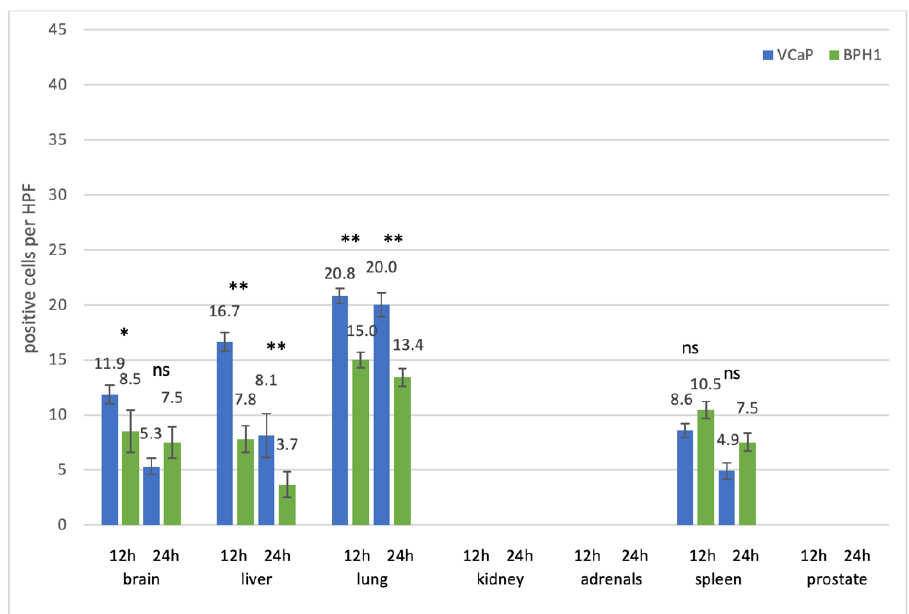
Figure 6. Uptake of fluorescence labeled VCaP and BPH1 EVs after intravenous injection. The number of EV-positive cells per high power field (HPF) is given for each organ and each time point. Columns for VCaP EVs are depicted in blue, those for BPH1 EVs in green. Medians +/− standard deviations are given. For each column, ten randomly chosen HPFs from two mice (five per mouse) were analyzed. Significances were calculated using a 2way ANOVA test with Bonferroni correction. * p < 0.05, ** p < 0.01, ns = not significant.